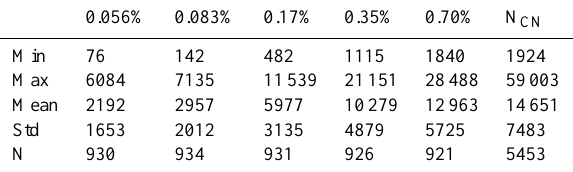
Table 2. Statistics of the Aerosol Number Concentration and CCN Number Concentration. The N CCN (cm − 3 ) at five supersaturations and the aerosol number concentration ( N CN ,cm − 3 ) are presented. The minimum, maximum, mean value and the corresponding stan- dard deviation are presented. The last line is the number of samples.